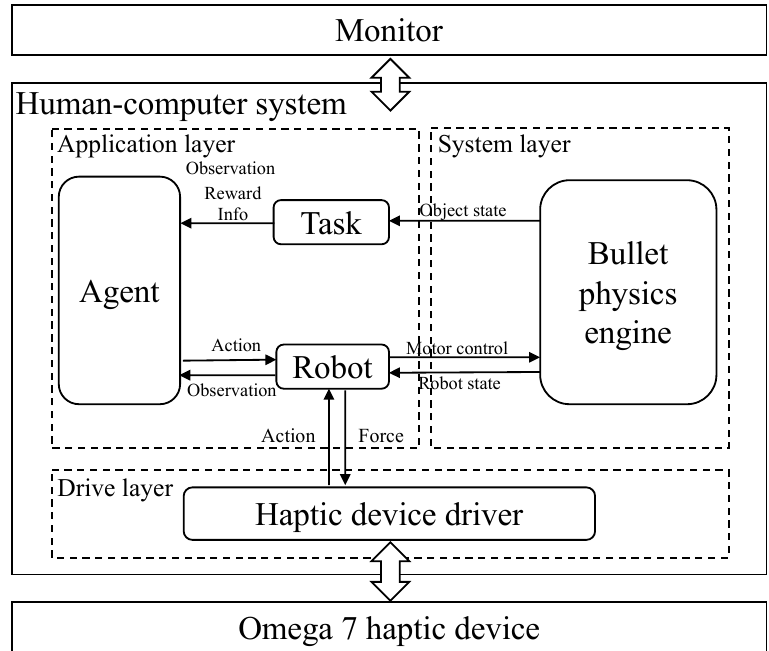
Figure 5. Simulation system architecture diagram.